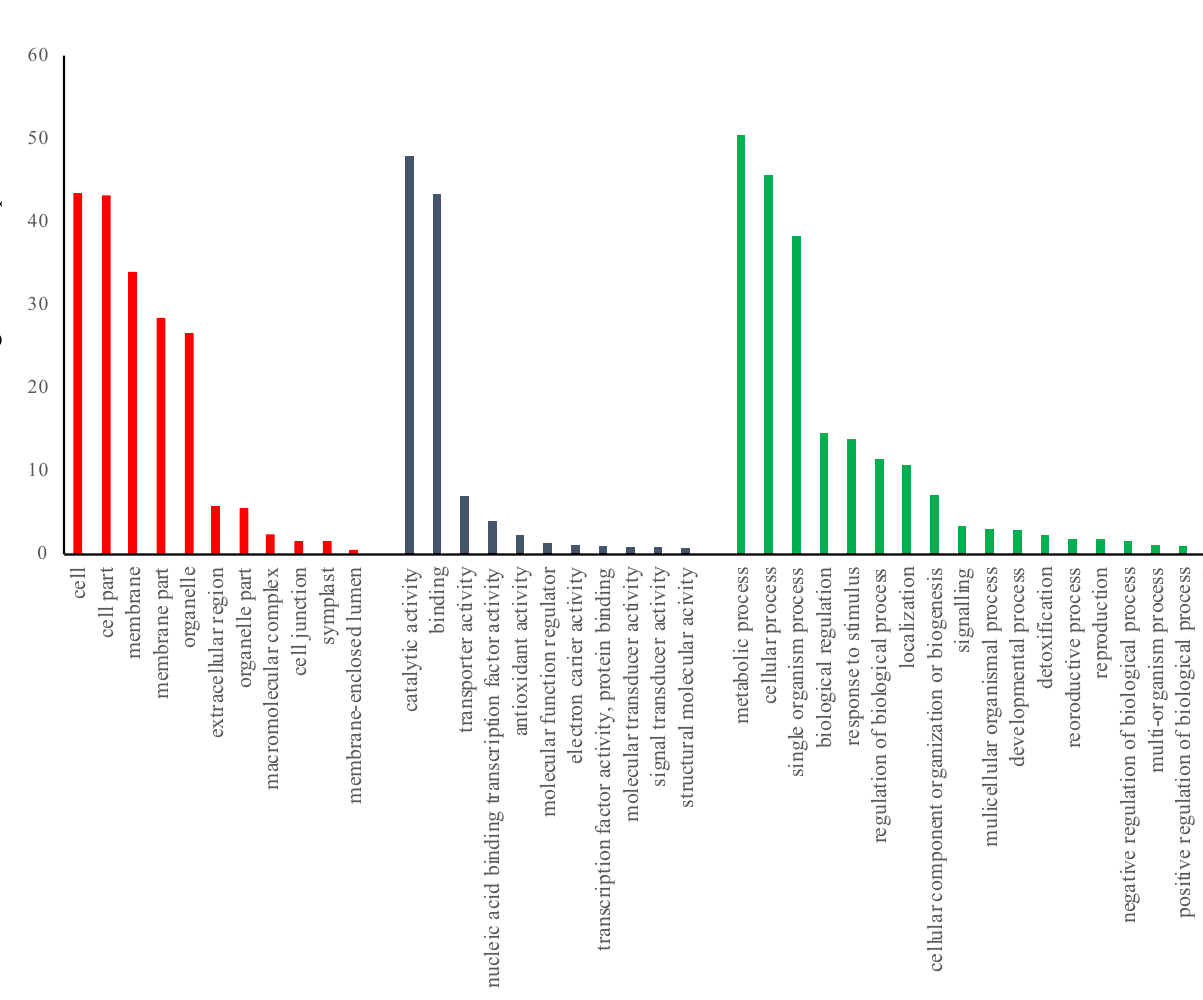
PLOS ONE | https://doi.org/10.1371/journal.pone.0213305 March 15,